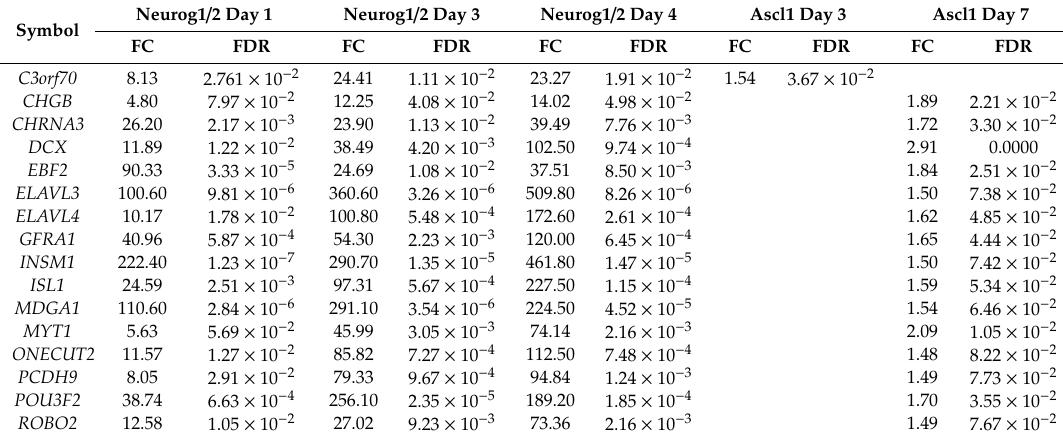
Table 1. Di ff erentially expressed genes regulated by Neugog1 / 2 and